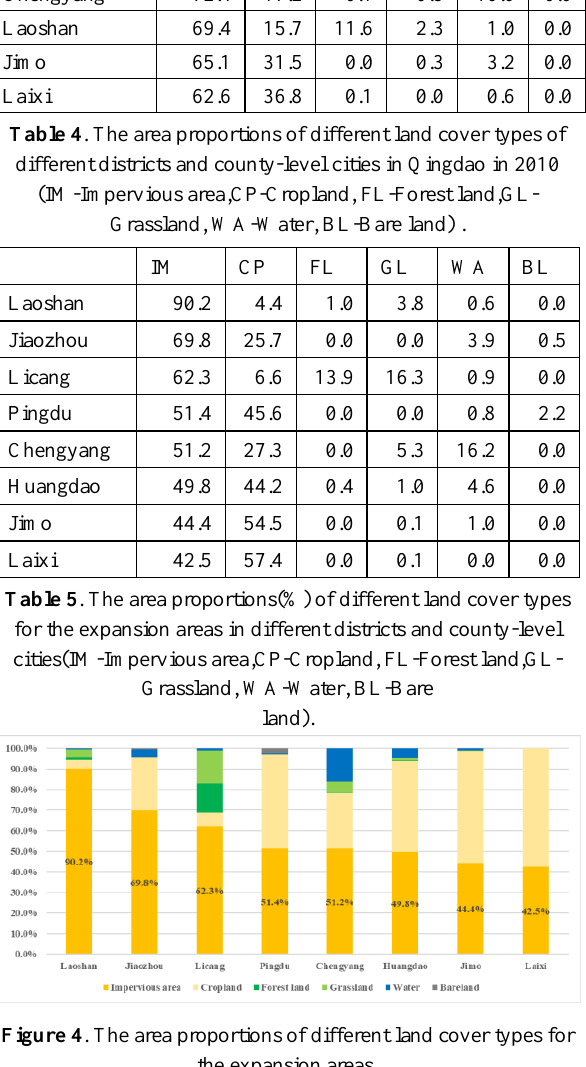
Figure 4 . The area proportions of different land cover types for the expansion areas.